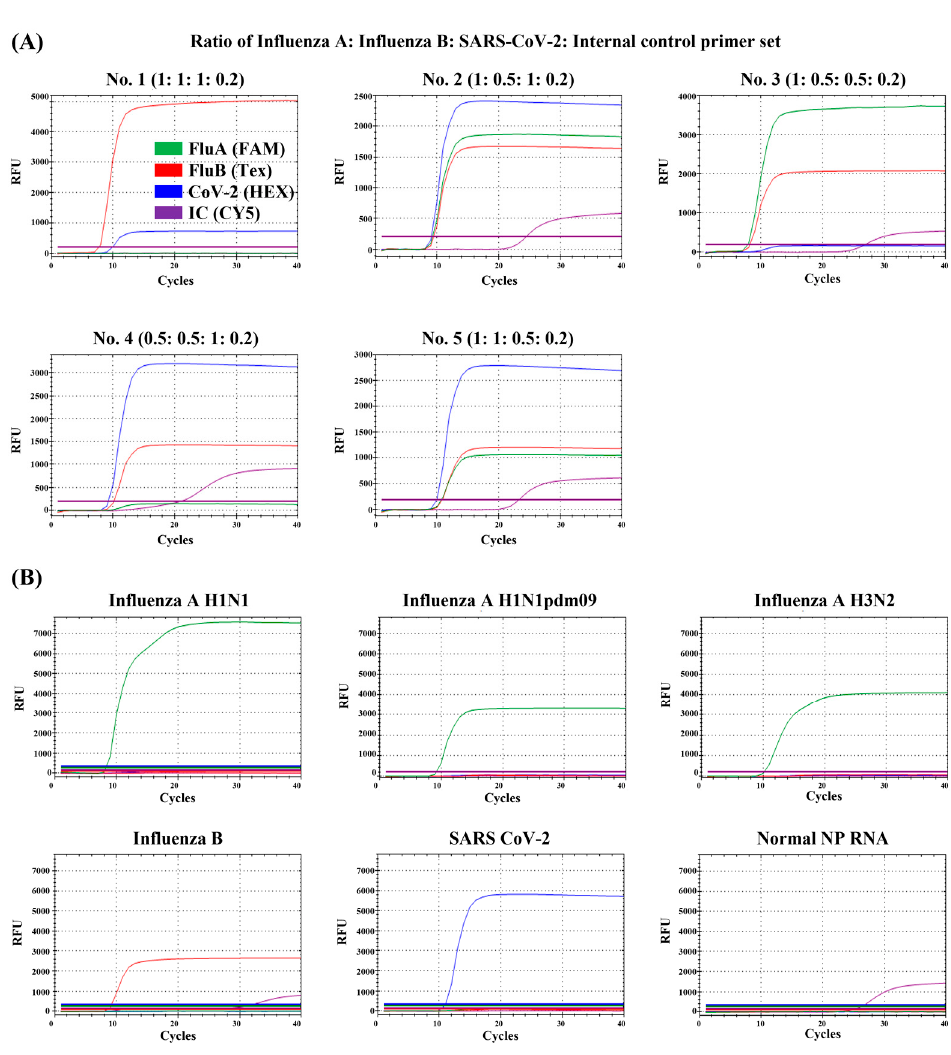
Figure 1. Optimization of the FluA/FluB/SARS-CoV-2 multiplex LAMP primer set. ( A ) Different